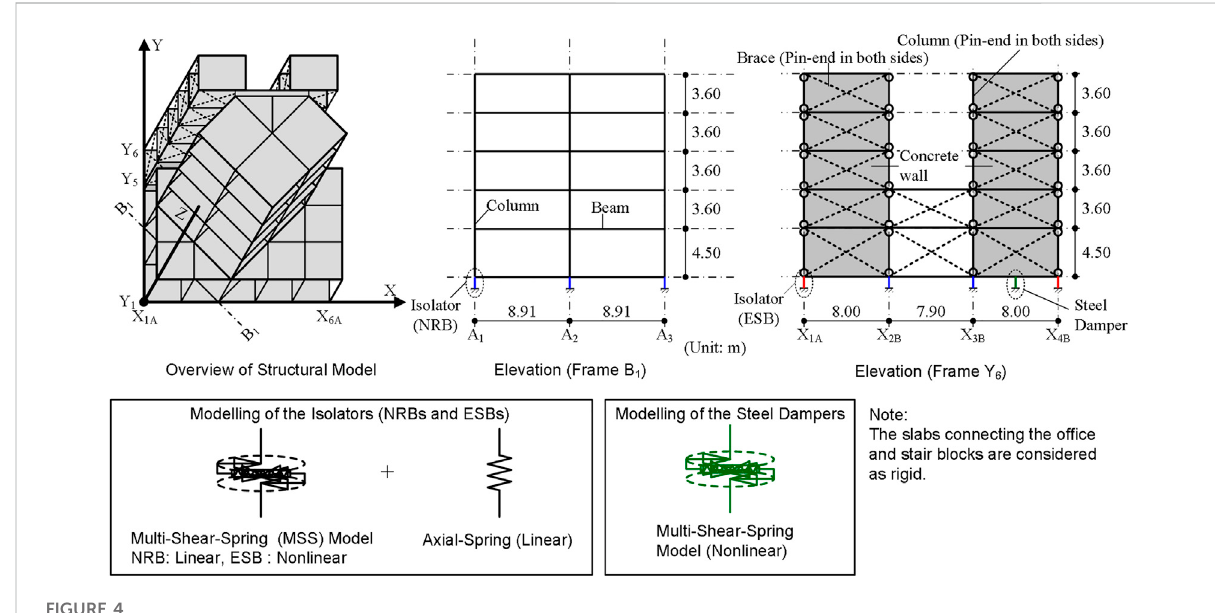
FIGURE 4 Structural modeling overview (Fujii,